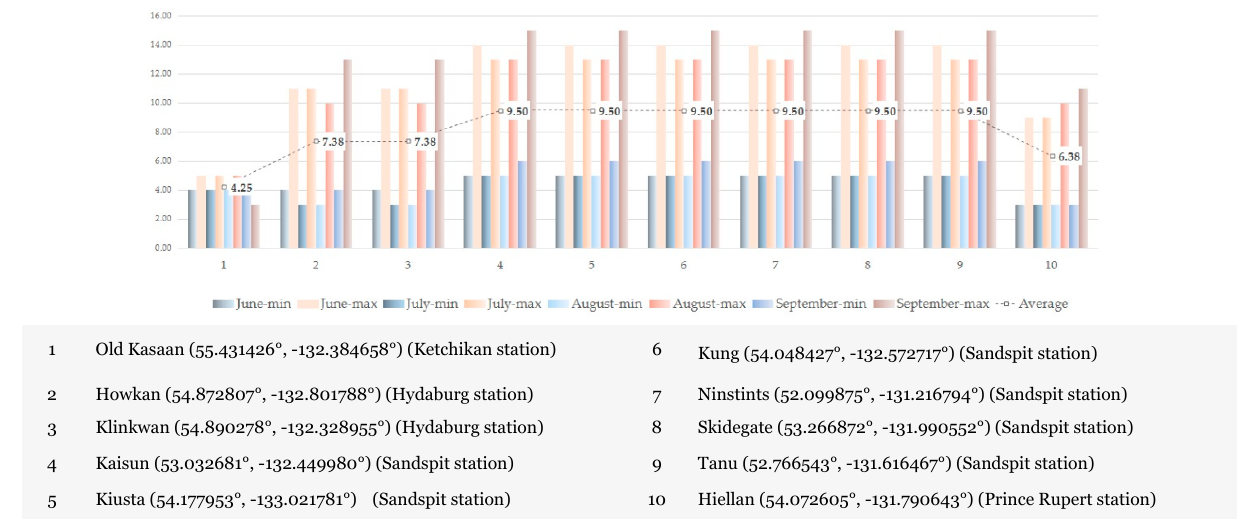
Figure 5. Average summer wind velocity values (m/s). Ten locations where the Haida built plank houses have been taken. The value that has been used (8.24 m/s) corresponds to the average of all of them [16].